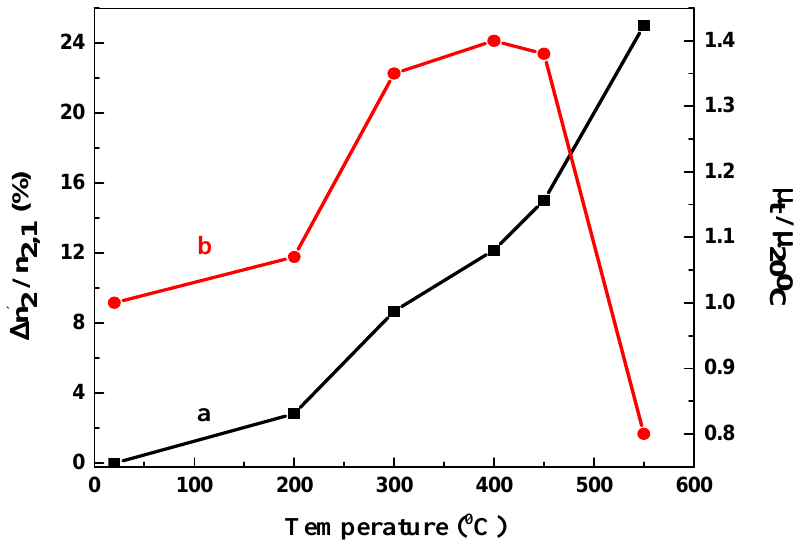
Figure 4. a) The annealing temperature dependence of the relative change in the electron state density near Fermi level, b) the dependence of the change in normalized magnetic permeability